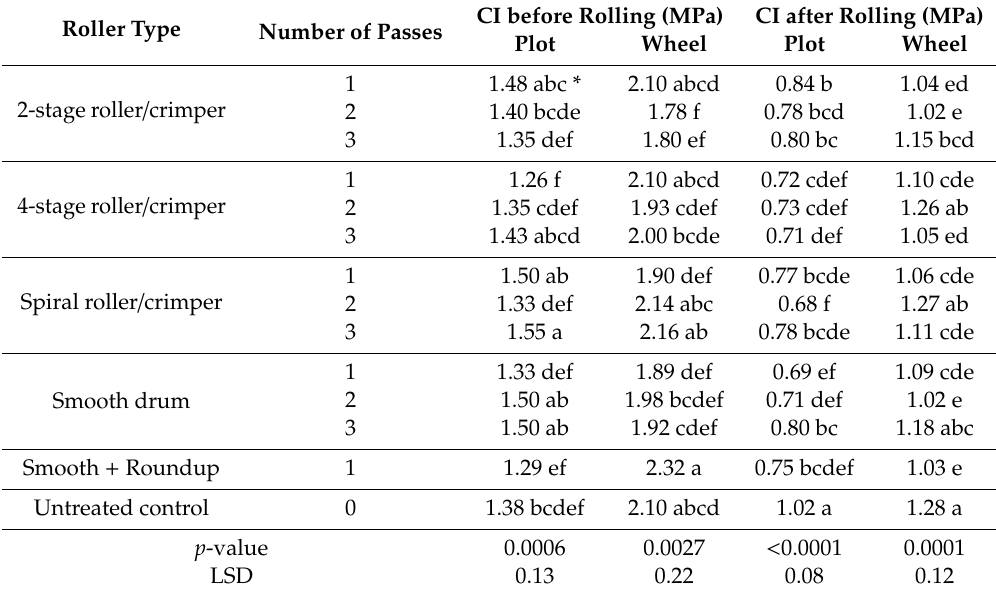
Table 15. Soil (CI) values averaged over depth (0–30 cm) in 2017 growing season. Roller Type